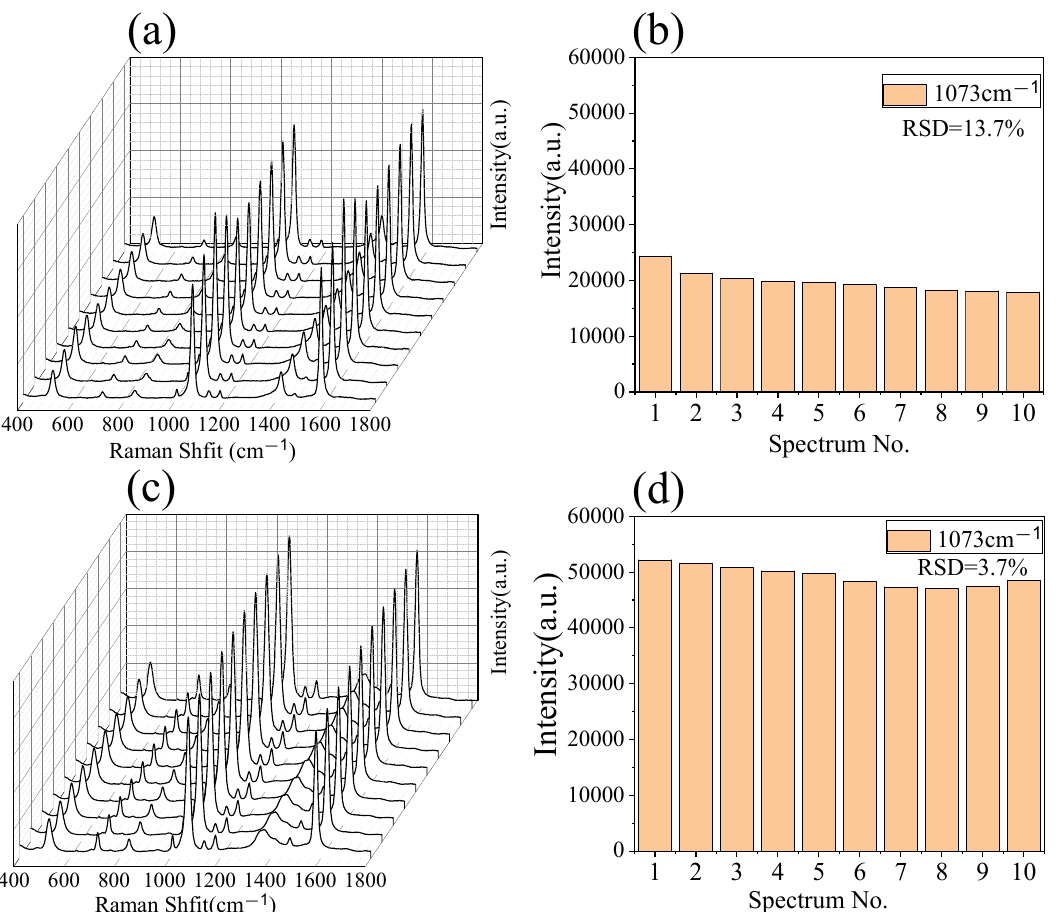
Figure 5. SERS spectra of MBA (100 ppm) measured from 10 random spots from the colloidal PS/Ag ( a ) and 2D PS/Ag assembled by LBL ( c ) substrate, and the corresponding statistical histogram of the intensity of peak at 1073 cm − 1 ( b ) and ( d ). Portable Raman spectrometer, laser λ = 785 nm, acquisition time: 2 s.